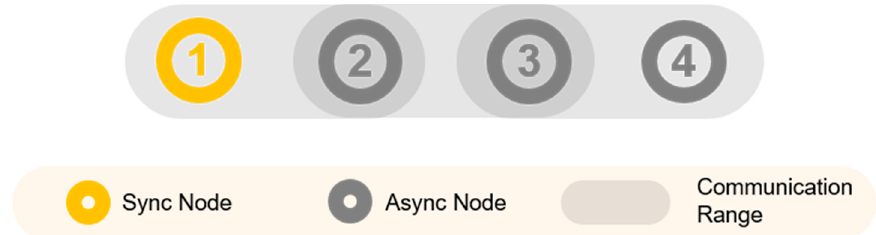
Figure 2. 3-hop Linear Topology.